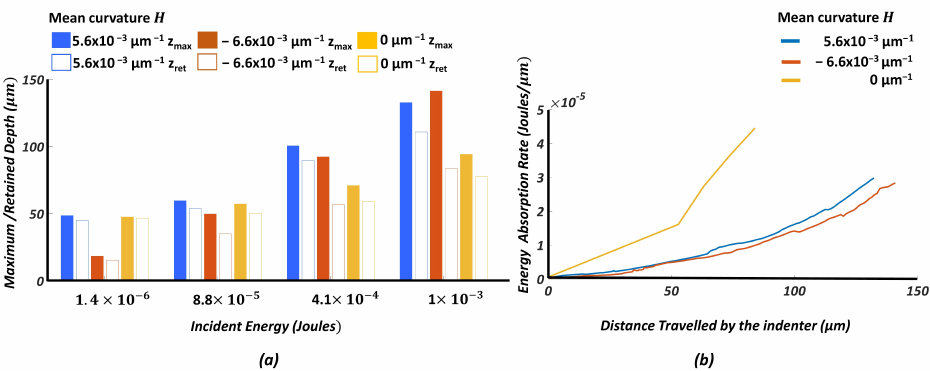
Figure 8. (a) Maximum depth observed in energy controlled numerical indentation experiment. (b) Figure 8. ( a ) Maximum depthobserved in energy-controlled numerical indentation experiment and Rate of energy absorption. ( b ) rate of energy